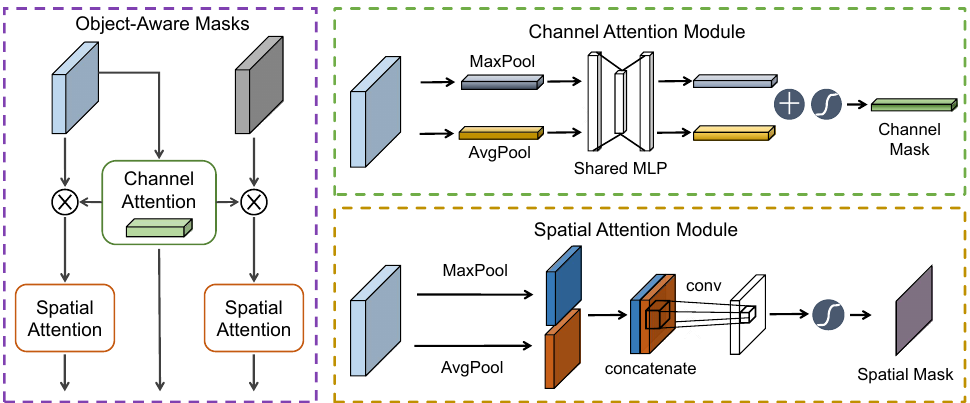
Figure 3. Illustration of the proposed object-aware mask module. The ( left ) figure illustrates the entire structure, while the ( right ) one shows each attention sub-module in